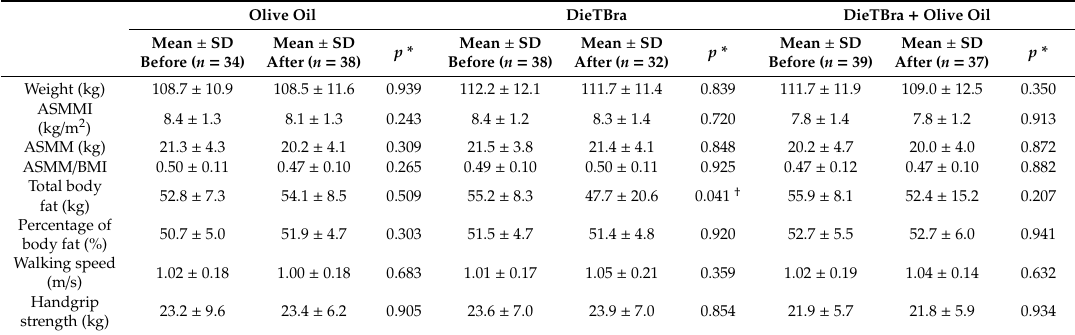
Table 2. Analysis of outcomes between baseline and the end of follow-up according to intervention group adults with severe obesity.